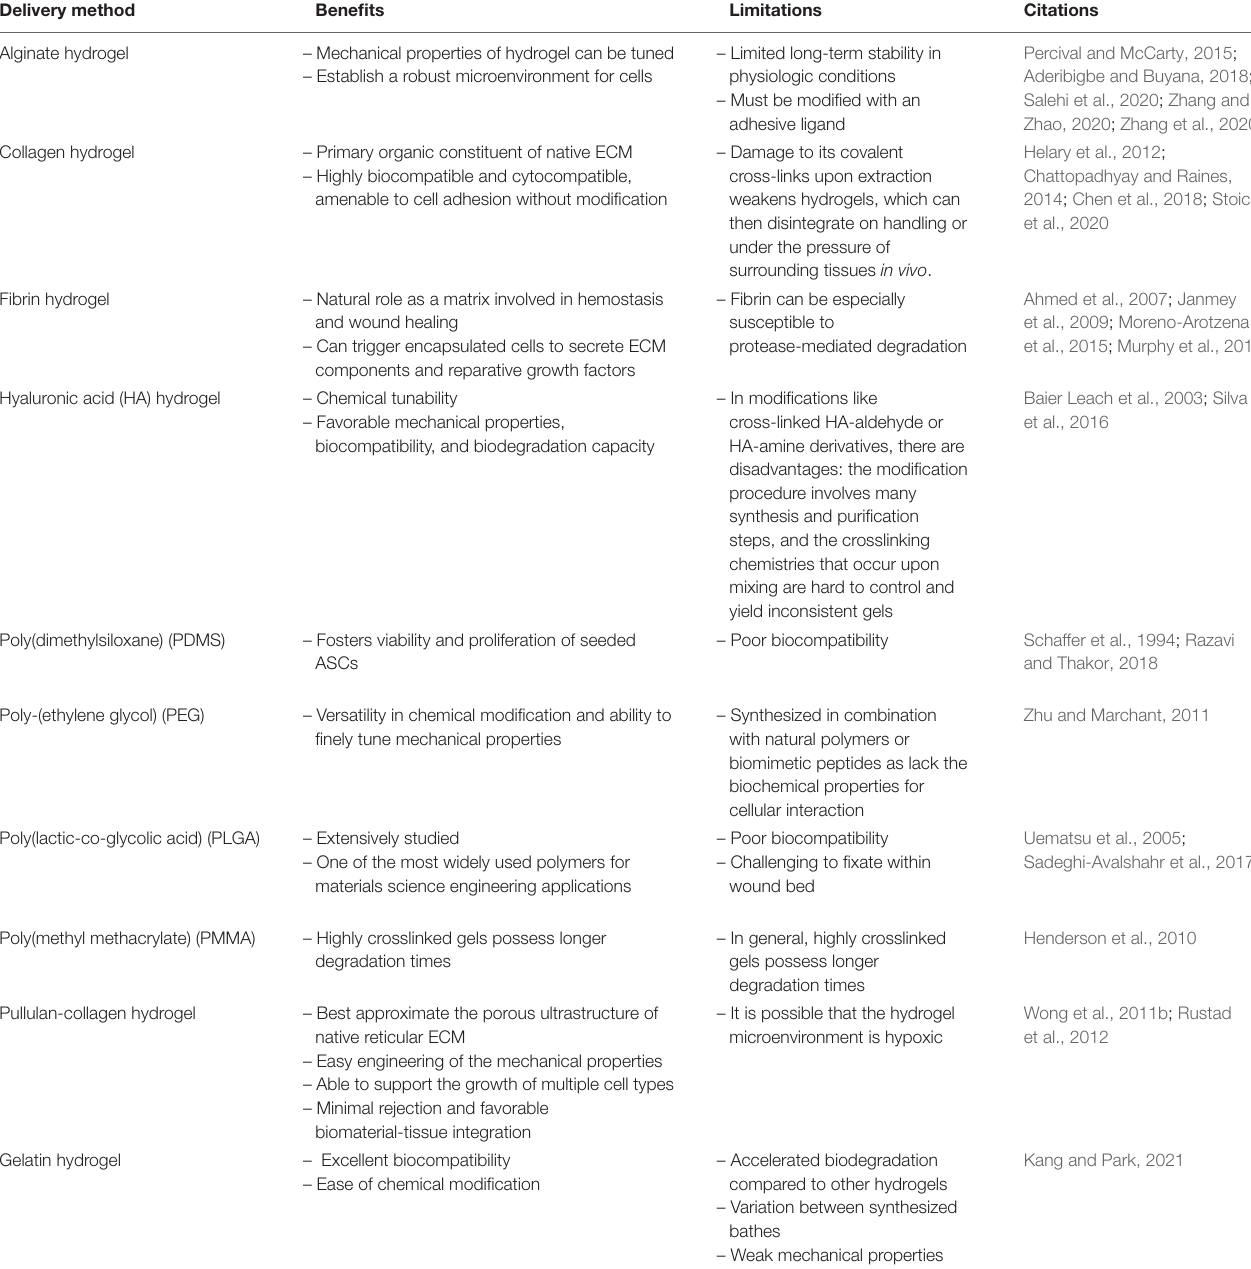
TABLE 2 | Different scaffolds to deliver cell therapies for wound